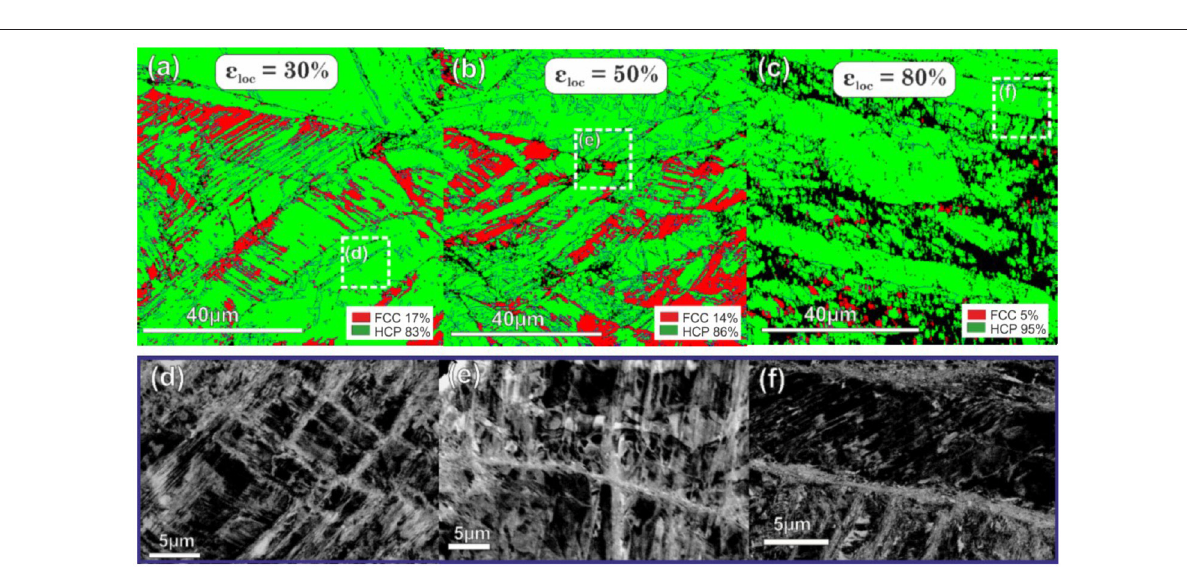
formation of stacking faults and mechanical twinning (Li et al., 2016,